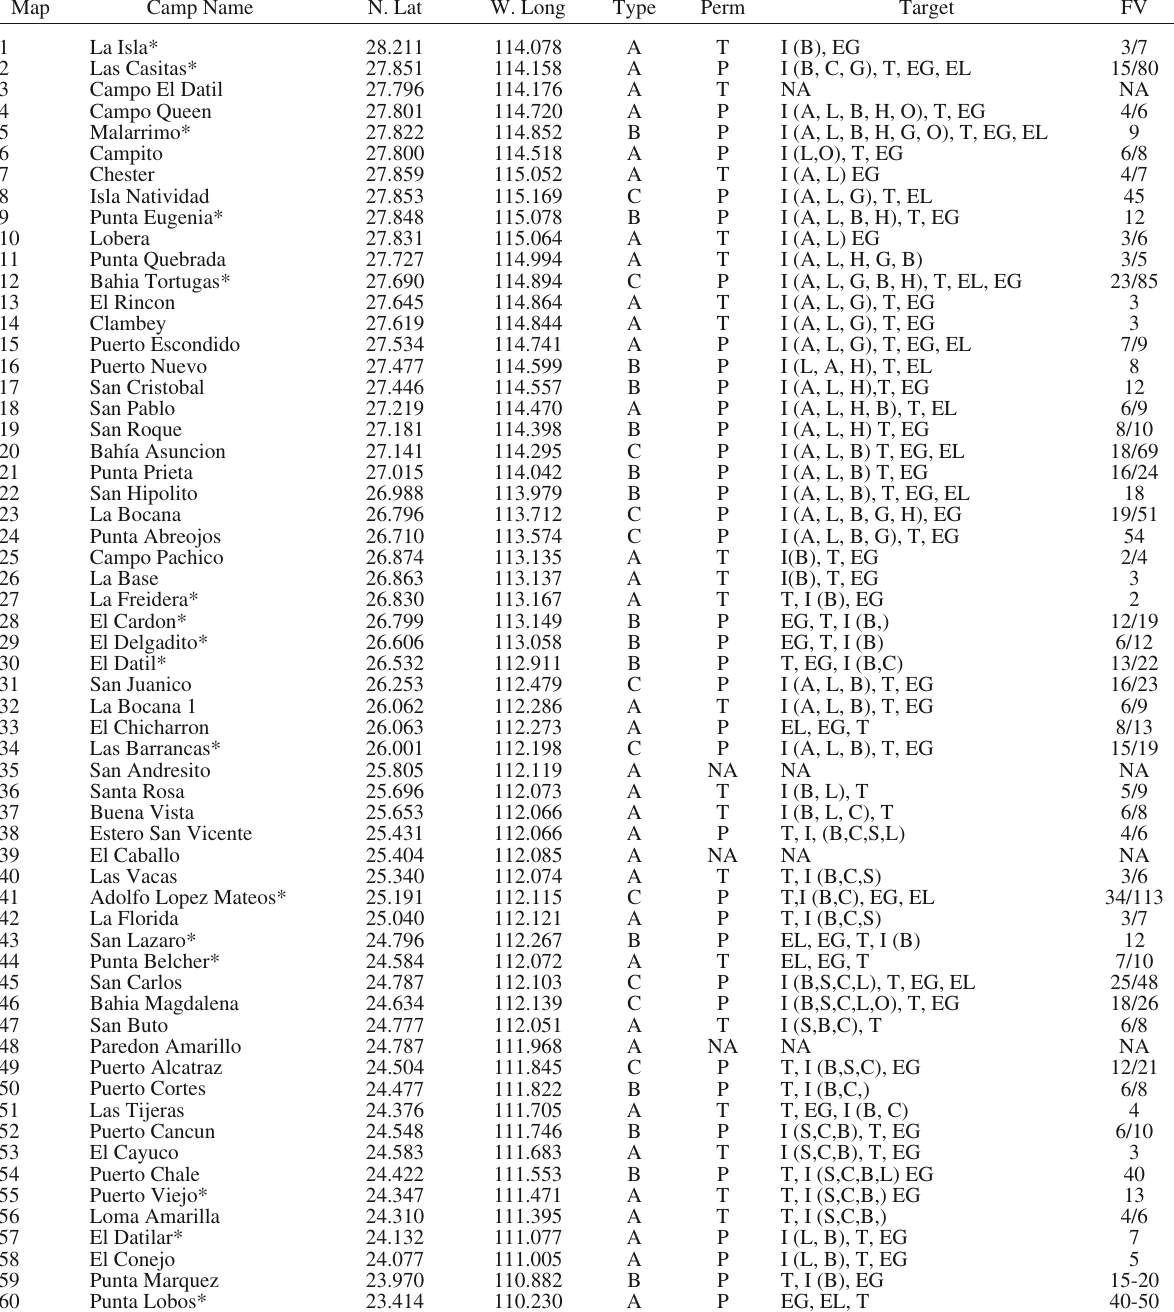
Table 1. – Characteristics of the surveyed artisanal camps. “Type” refers to infrastructure: A, little to no infrastructure; B, moderate infrastruc- ture; C, significant infrastructure. “Perm” refers to whether a camp is permanent (P) or temporary (T). “Target“ refers to the fishery typology : EG, elasmobranch gillnet; EL, elasmobranch longline; T, teleosts; I, invertebrates (A, abalone; L, lobster; C, crab; G, gastropod; B, bivalve; H, sea cucumber; O, octopus; S, shrimp). FV = number of fishing vessels present during the surveys (or minimum/maximum in case of seasonal fluctuations in effort). Asterisks denote artisanal camps where elasmobranch biological data were